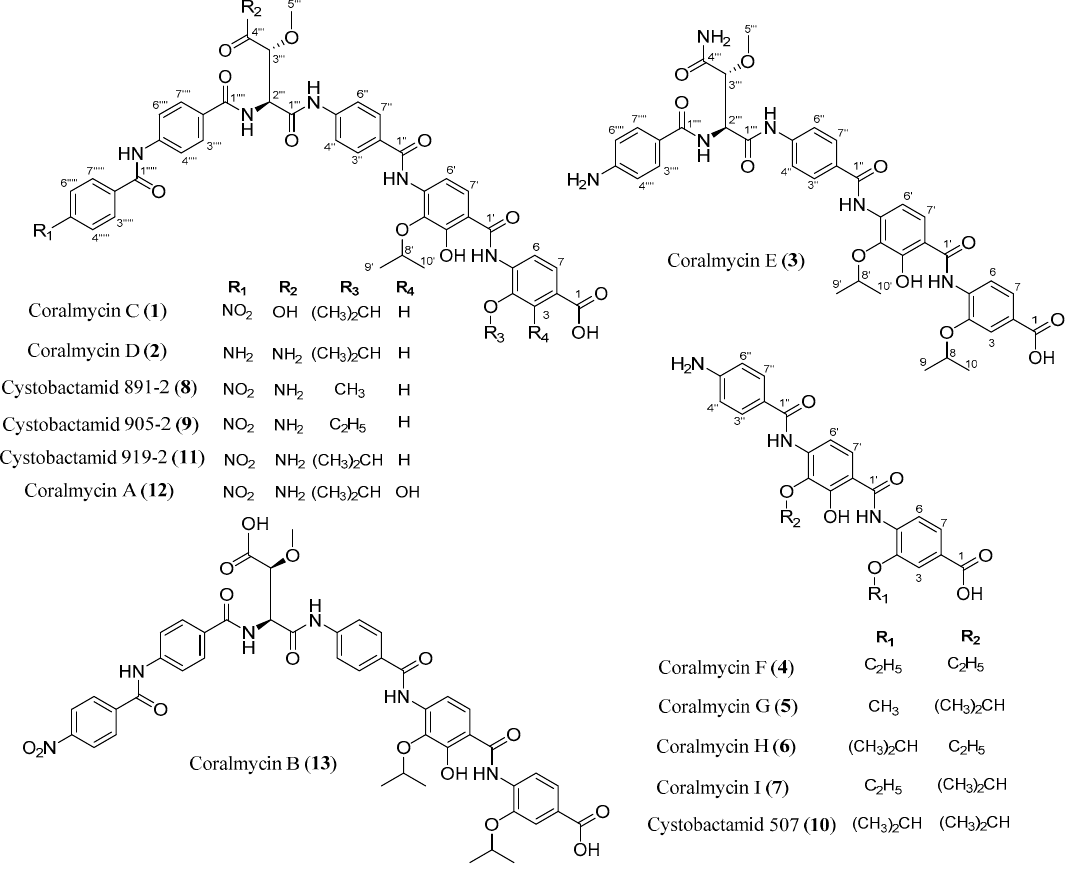
Figure 1. The structures of coralmycins C ( 1 ), D ( 2 ), E ( 3 ), F ( 4 ), G ( 5 ), H ( 6 ), and I ( 7 ), and related